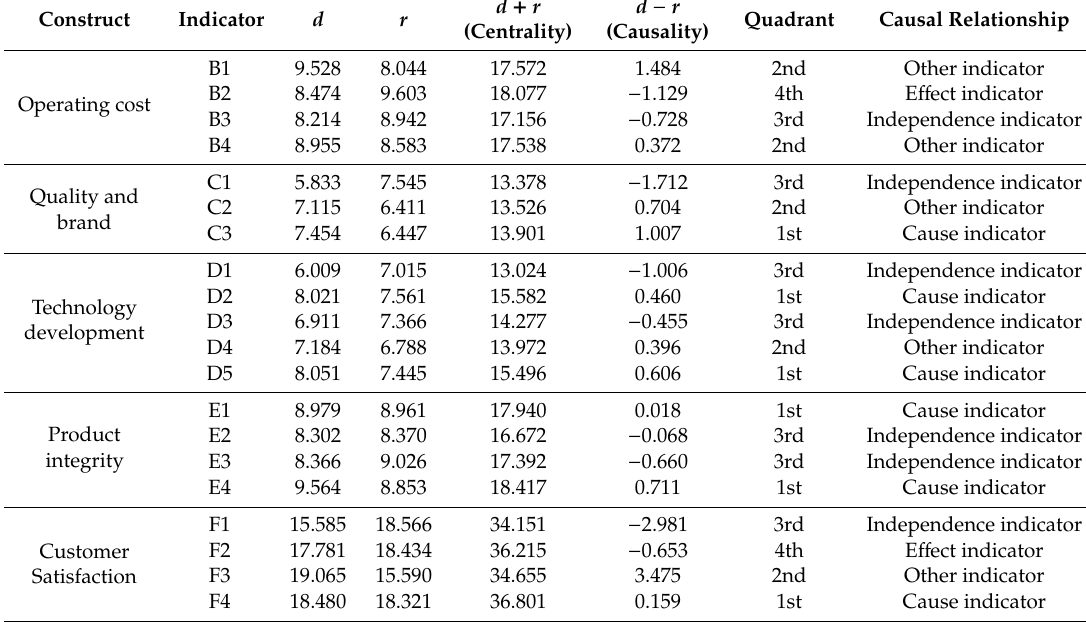
Table 9. The degree of centrality and causality among indicators under various